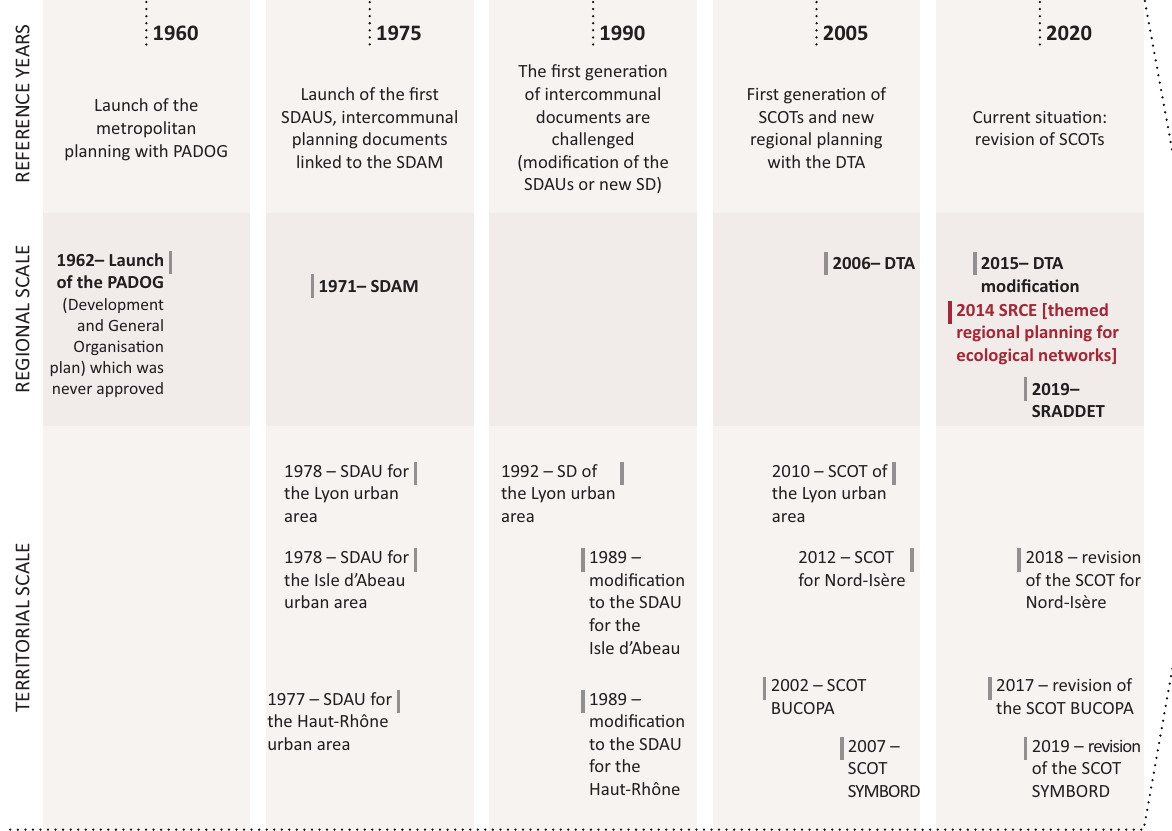
Figure 2. Planning documents for the Plaine Saint-Exupéry territory. Source: